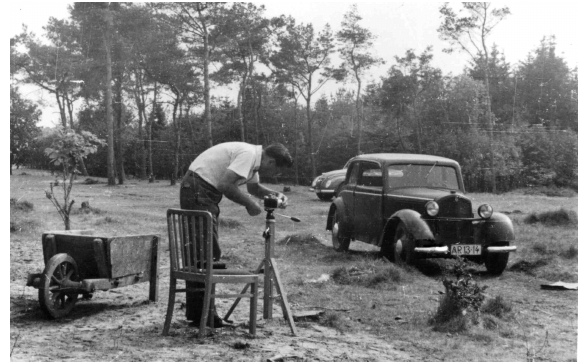
Figure 5. Path of the umbra over northern Europe during the solar eclipse on 30 June 1954.